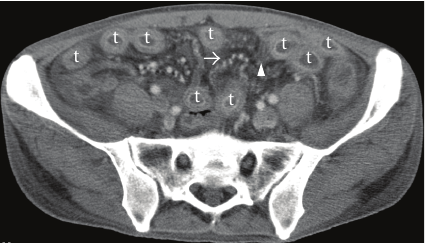
Figure 1: CT scan reveals bowel wall thickening and enhancement and engorgement of mesenteric vessels. Target sign (t), comb sign (arrow head), and nodular sign (arrow).